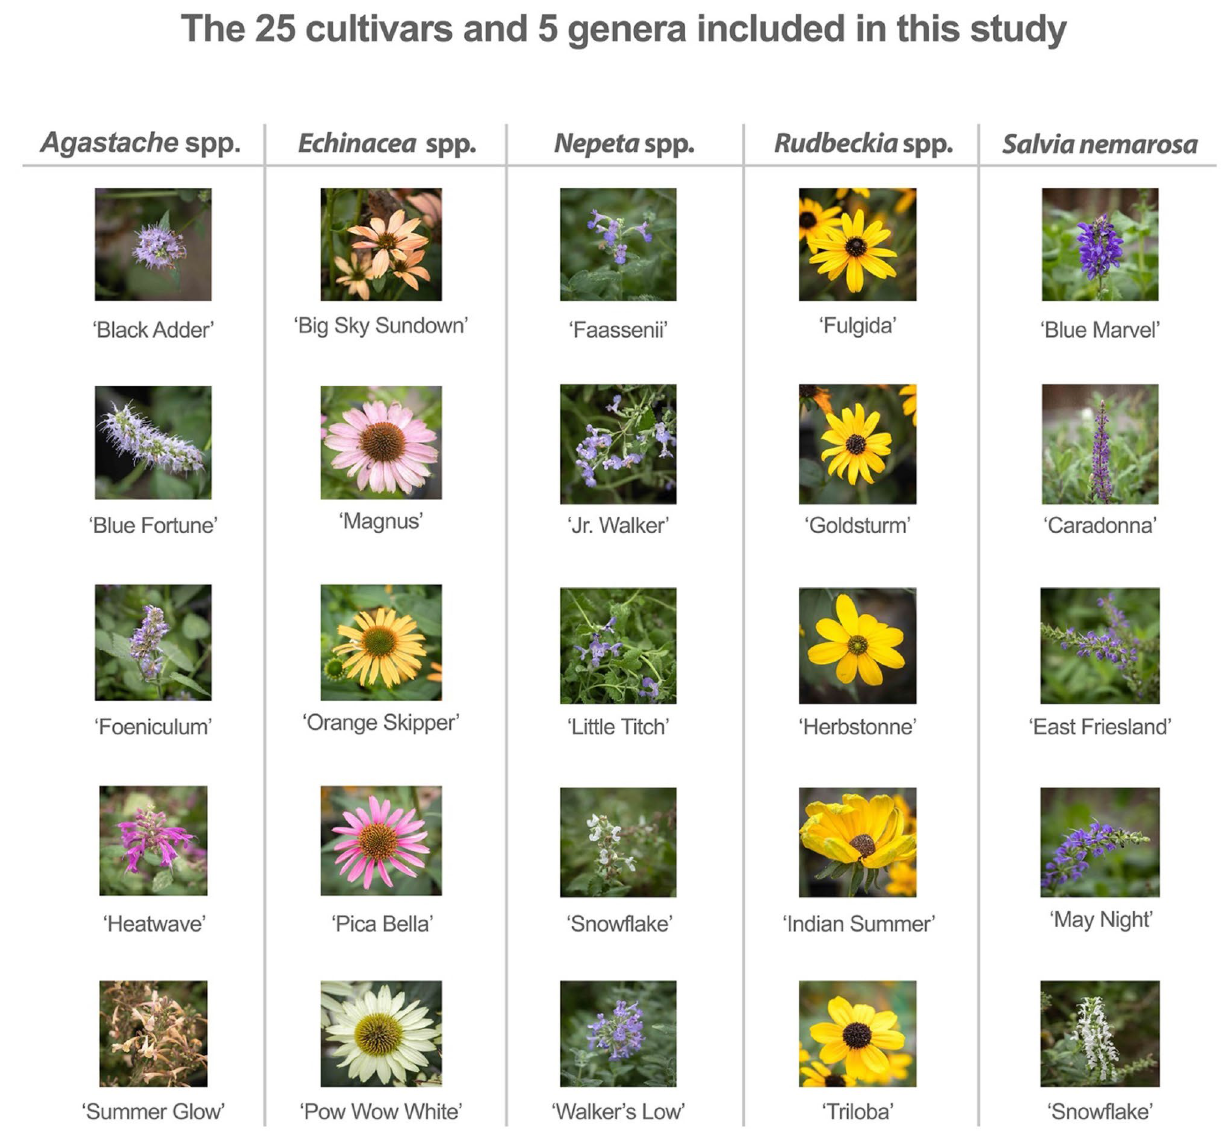
Figure 1. The 25 cultivars and five plant genera included in this study were selected from a 2014 NASS grower survey to reflect taxa that are commercially popular in the North American floriculture